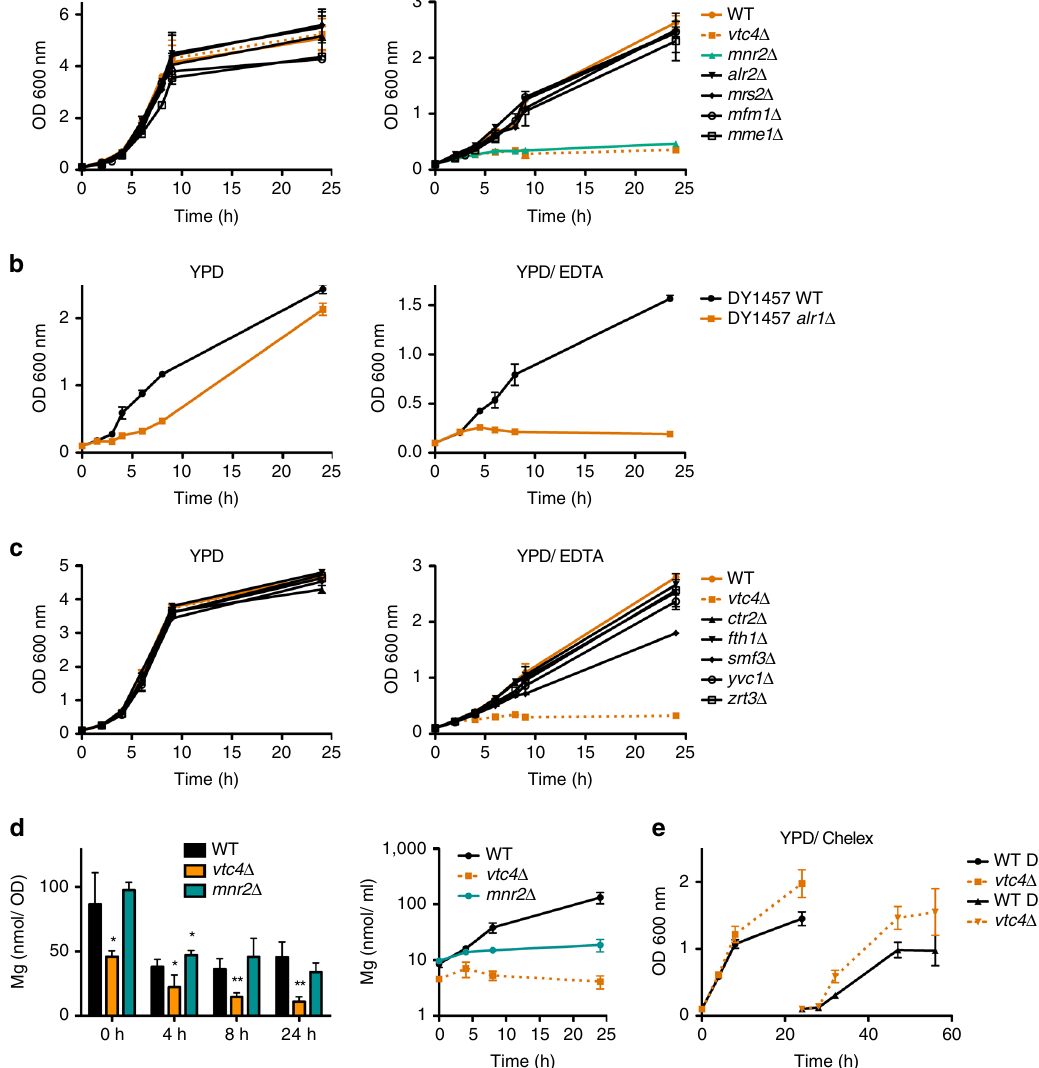
Fig. 4 Role of metal transporters for growth on YPD/EDTA. a Magnesium transporter mutants were pre-cultured on YPD, transferred to YPD or YPD/ EDTA, and the OD 600 nm was measured at the indicated times after transfer. b Growth of alr1 Δ cells was assayed as in ( a ). c Growth of vacuolar metal exporter mutants was assayed as in ( a ). d Time course ICP-MS analysis of the magnesium content of mnr2 Δ cells at the indicated times after transfer from YPD to YPD/EDTA. Values per cell and per culture volume are shown. Note that the values for wild-type and vtc4 Δ are the same as in Fig. 3b because mnr2 Δ cells had been tested as part of the same experiments. e Growth of wild-type and vtc4 Δ cells on Chelex-treated YPD. Cells were pre-cultivated in YPD, washed and transferred to YPD/Chelex. The OD 600 nm was followed for one day (D1). The cells were then re-inoculated in fresh YPD/Chelex and growth was followed for another day (D2). The results represent mean ± SD of at least three independent experiments. Differences in d were evaluated using Student ’ s t test comparing vtc4 Δ and mnr2 Δ cells with wild-type cells at each time point; * p ≤ 0.05; ** p ≤